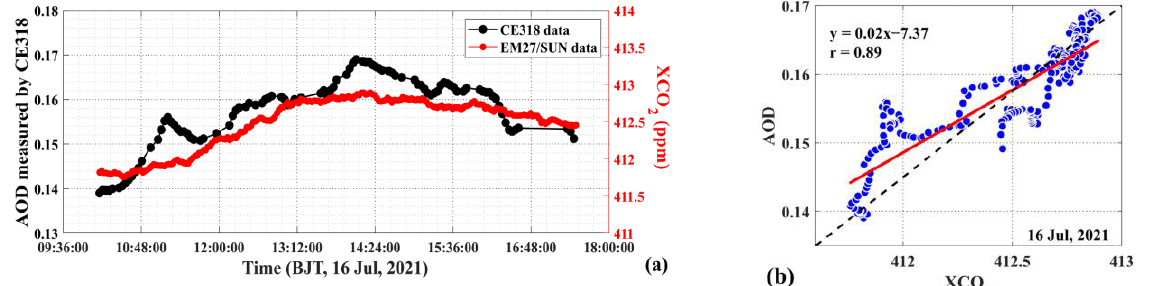
Figure 14. Measurement results of XCO 2 and AOD at the CRCS ground station on 16 July 2021 ( a ). The red dots represent the XCO 2 results measured by EM27/SUN, and the black scatter points represent the AOD results measured by CE318. ( b ) The correlation analysis result of XCO 2 and AOD.